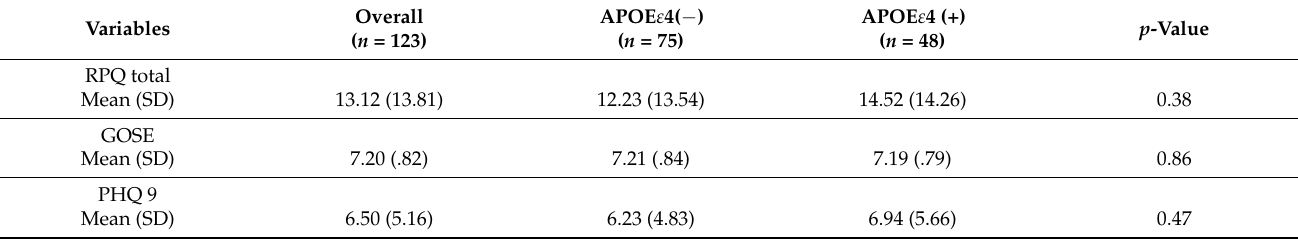
Table 2. Self-reported outcome measures of patients on APOE ε 4